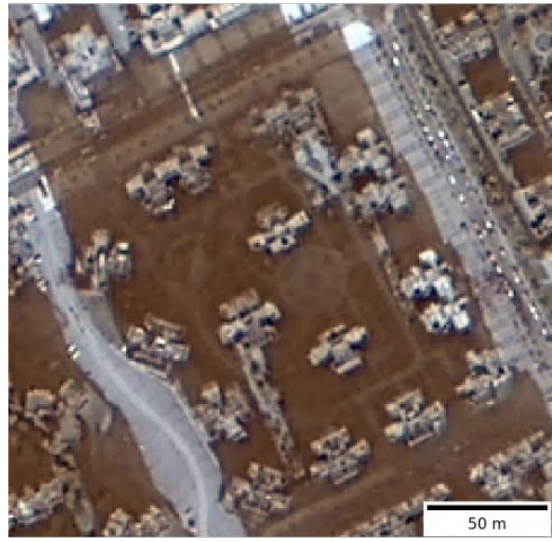
Figure 4. Image in dataset for high buildings. Table 3. Configuration of dataset.